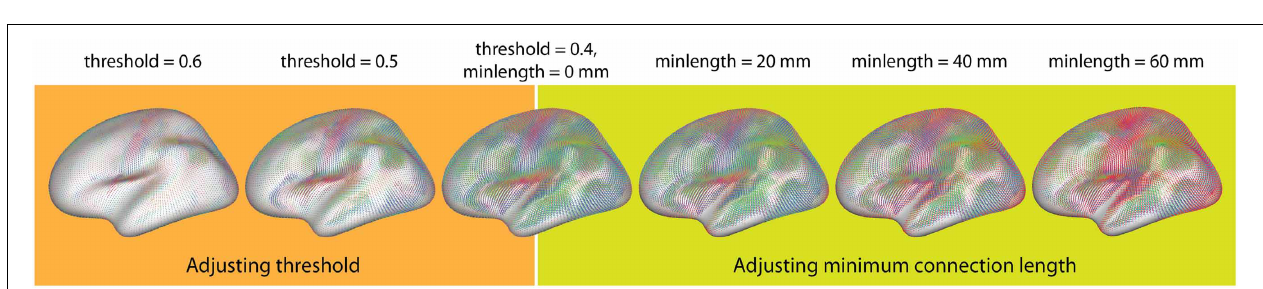
3D views, and the display of the associated connectivity map in the right view. This allows for simultaneous overview of differences between neighboring nodes and their detailed individual connectivity.